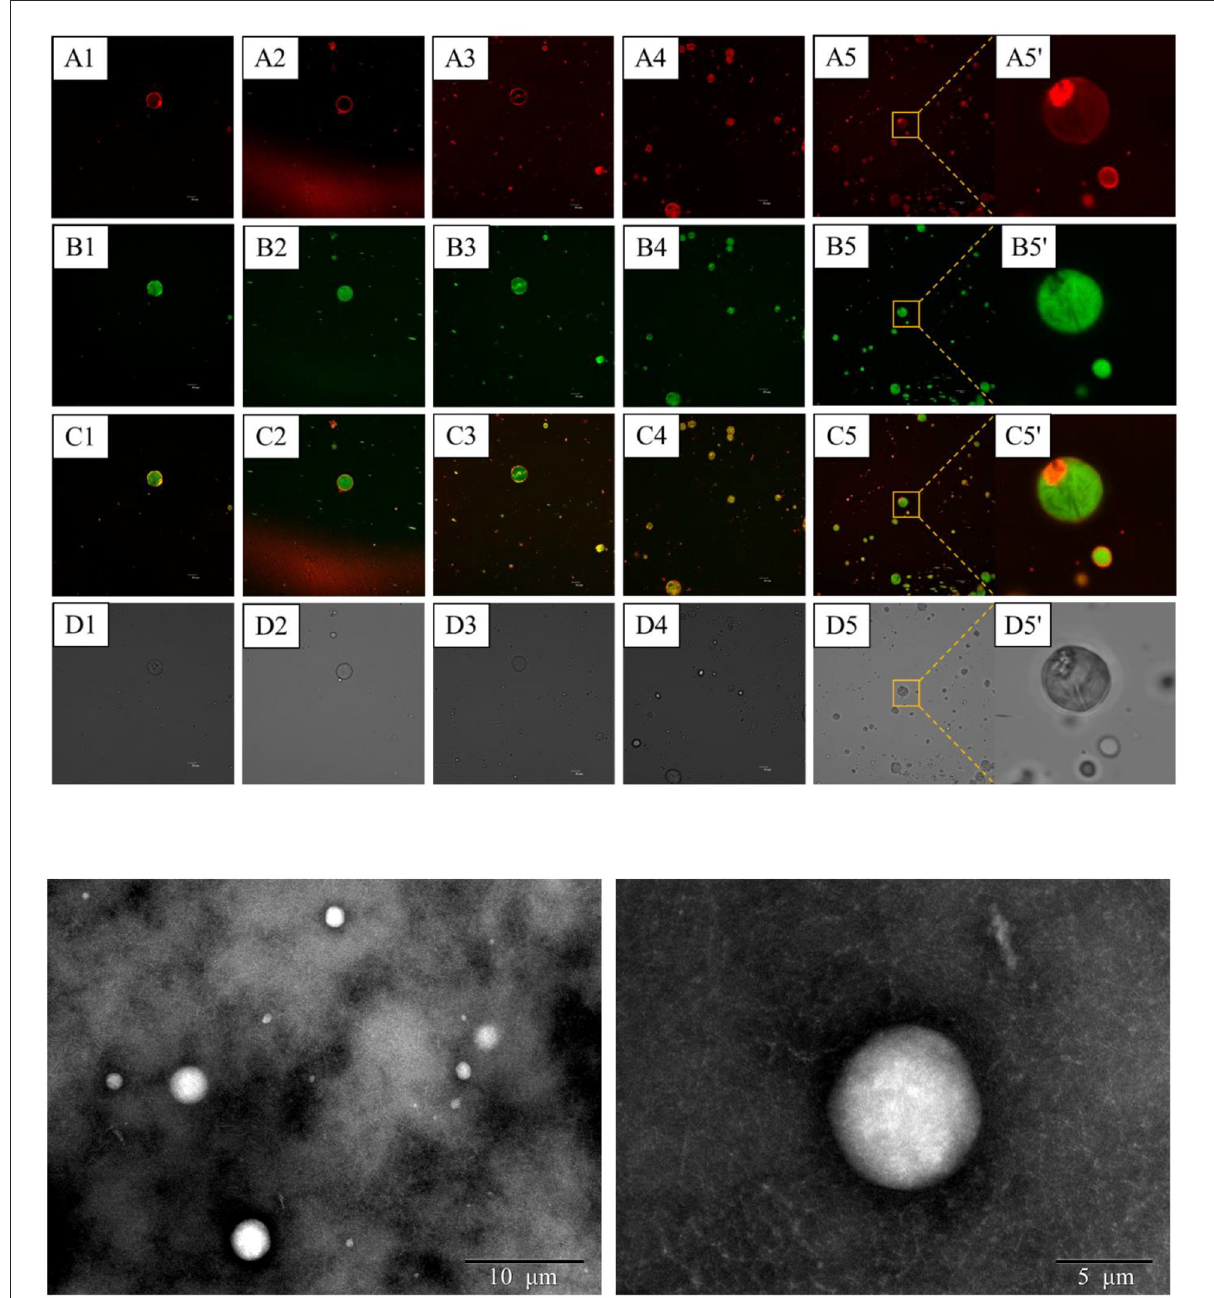
FIGURE4 Confocal laser scanning microscope (CLSM) images (A) of S/O/W calcium-lipid emulsions stabilized by different concentrations of PGA-XG complexes. The calcium carbonate (CaCO 3) dyed by Rhodamine B (RB) (excitation at 543nm) showed red fluorescence (A) , whereas the oil droplet dyed by Nile Red (excitation at 488nm) showed green fluorescence (B) . Combined image (C) . Bright field (D) . The scale bar is 10 µ m (1–5: 0.4, 0.5, 0.6, 0.7, and 0.8 wt%, respectively; 5’: high magnified image at 0.8 wt%). Transmission electron microscopy (TEM) images (B) of S/O/W calcium-lipid emulsions stabilized by 0.8 wt% concentration of PGA-XG complexes.